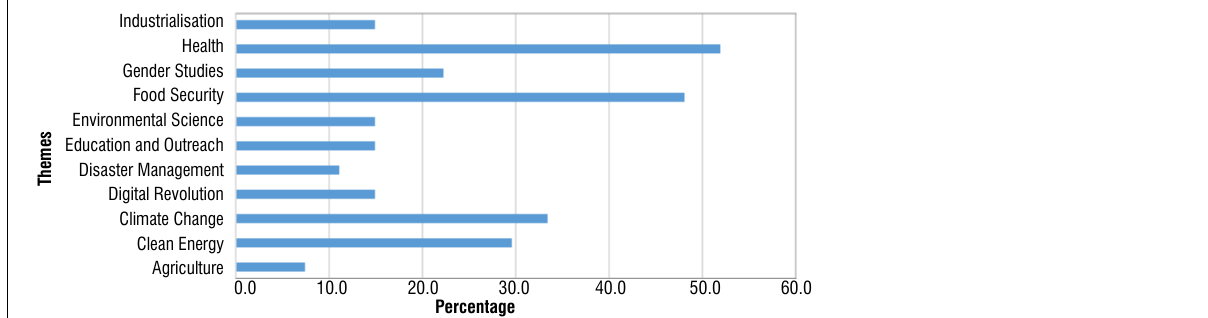
Figure 4: Proportion (%) of African-Arabian countries from which authors submitted in each